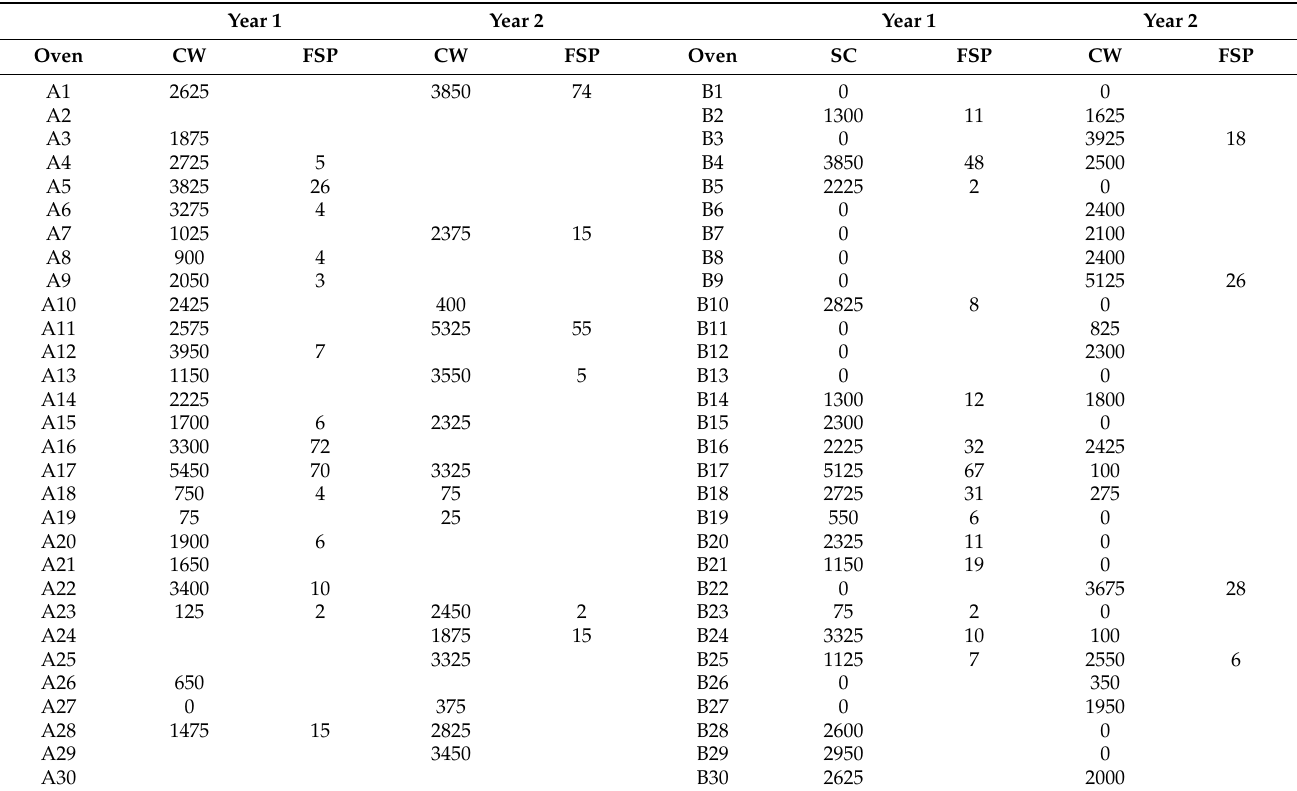
Figure 7. Causes of sticky ovens in the second year.